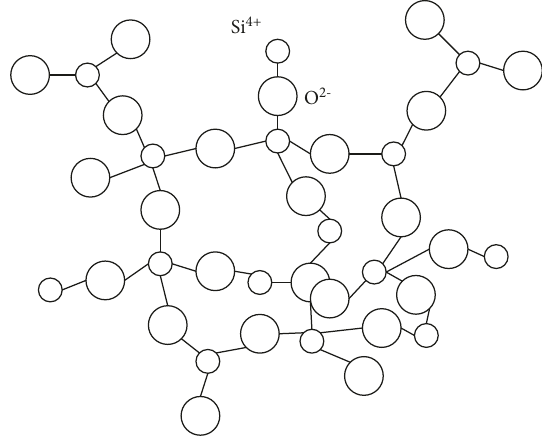
Figure 2: Fused silica structure.